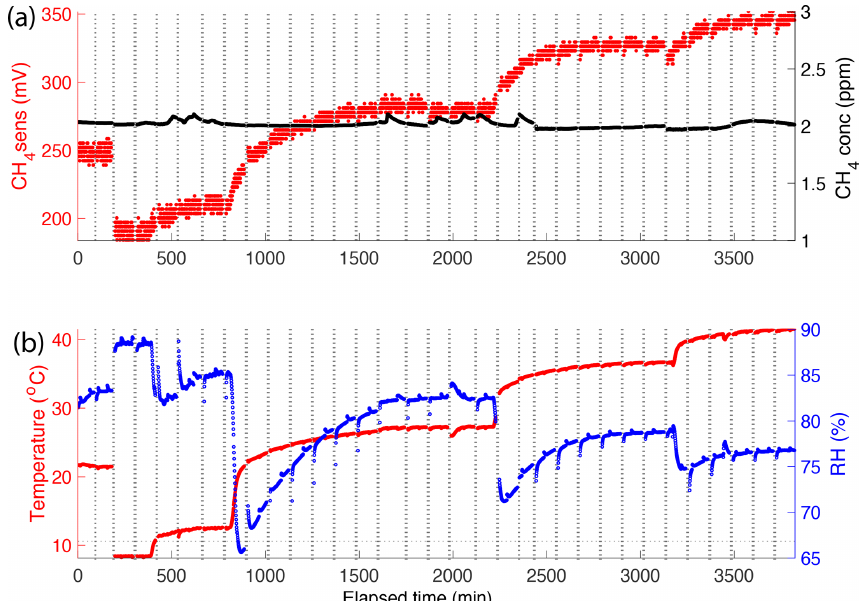
Figure 4. Methane (mV response and concentration), temperature ( ◦ C), and RH (%) sensor responses in the initial phase of the sensor test experiment in which the temperature of the water tank was regulated in the range of 5 to 35 ◦ C. (a) CH 4 sensor signal and actual CH 4 concentration around 2ppm and (b) temperature and RH in the chamber over the experimental period. Dotted vertical lines denote periods when the chamber was opened for